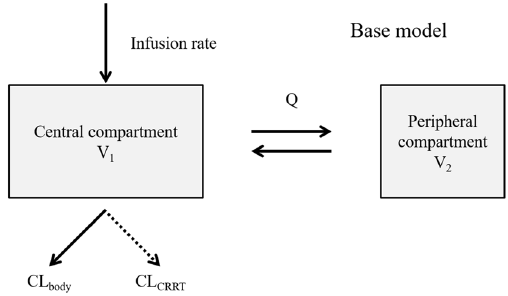
Figure 1. Base model for this study. V 1 distribution volume of central compartment, V 2 distribution volume of peripheral compartment, Q distribution clearance between the central and peripheral compartments, CL body clearance from body, CL CRRT clearance by continuous renal replacement